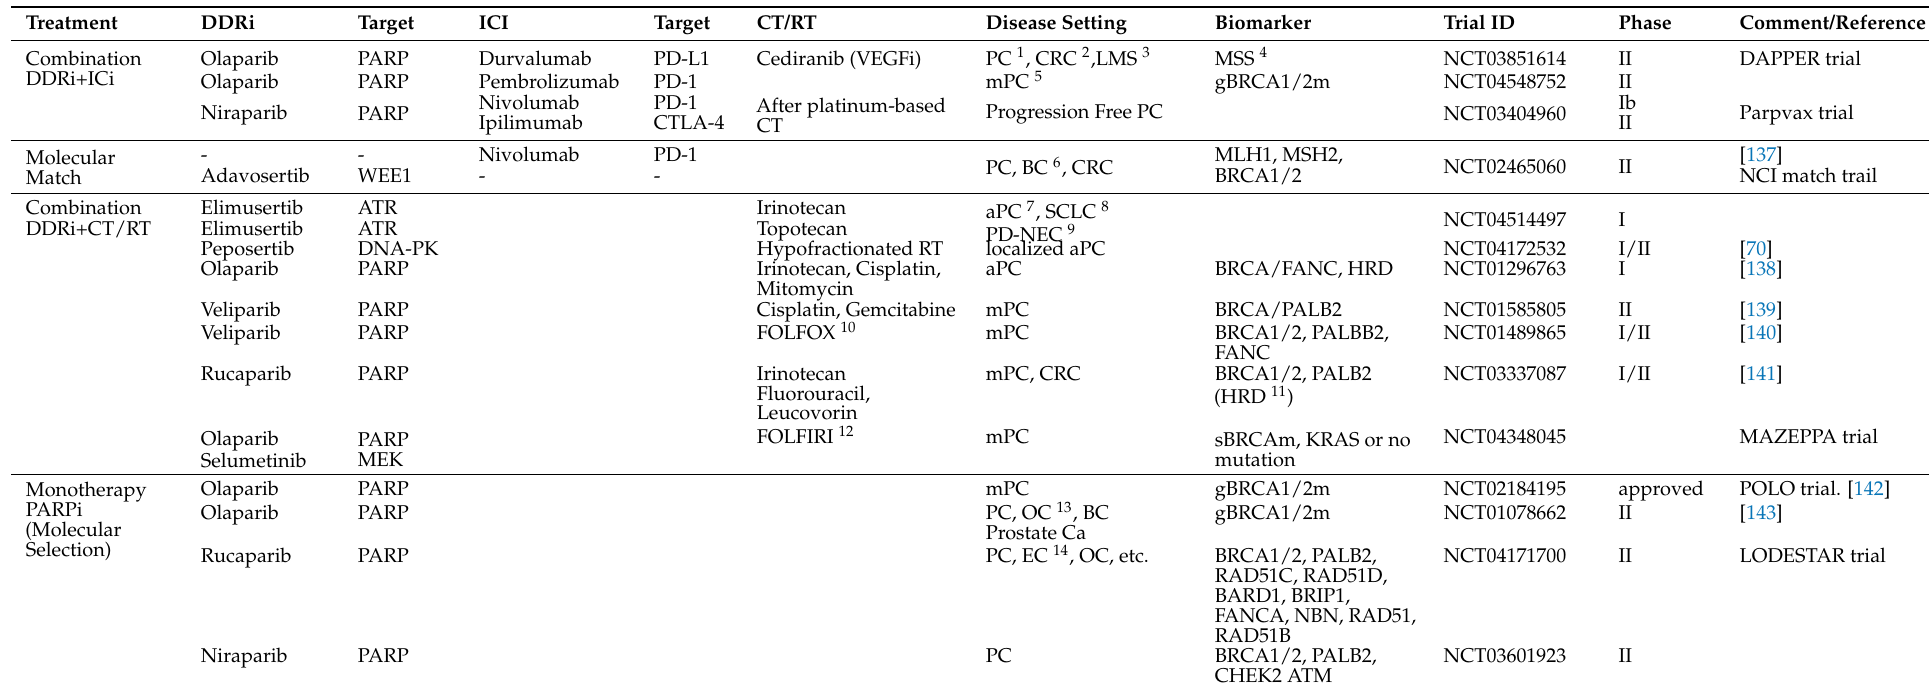
Table 3. Clinical trials of pancreatic cancer using immunotherapy or synthetic lethality